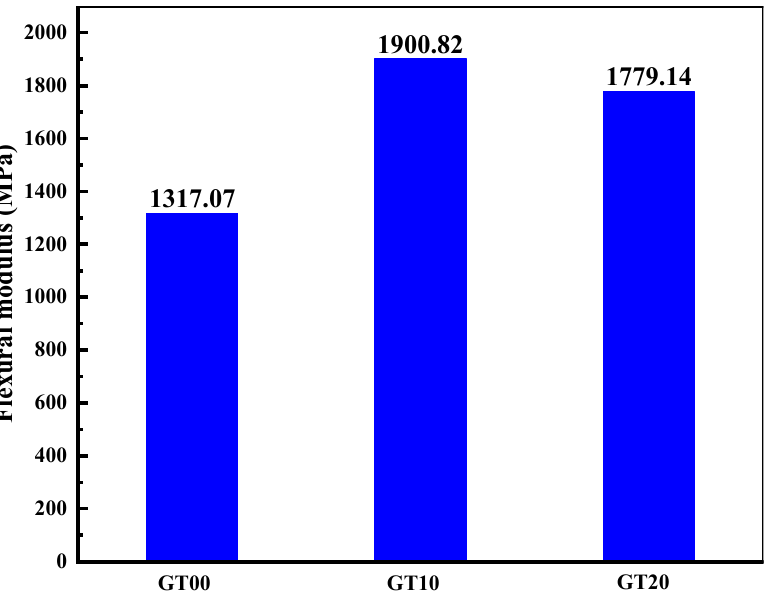
Figure 18. Flexural modulus.